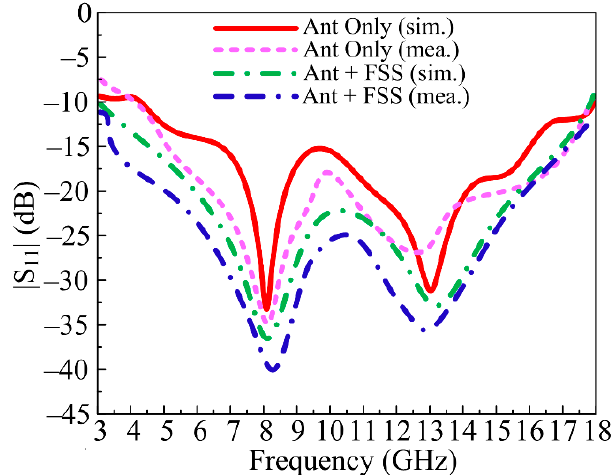
Figure 9. Simulated and measured S-parameter of the proposed UWB antenna with and without FSS.